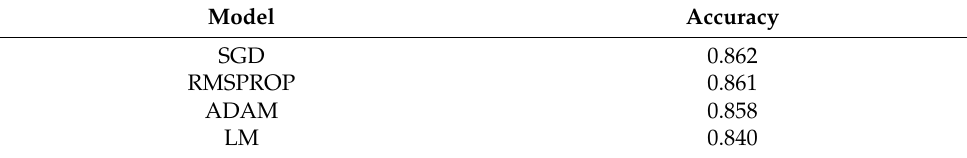
Table 5. Average accuracy values for each experiment on ensemble models (the higher the best).